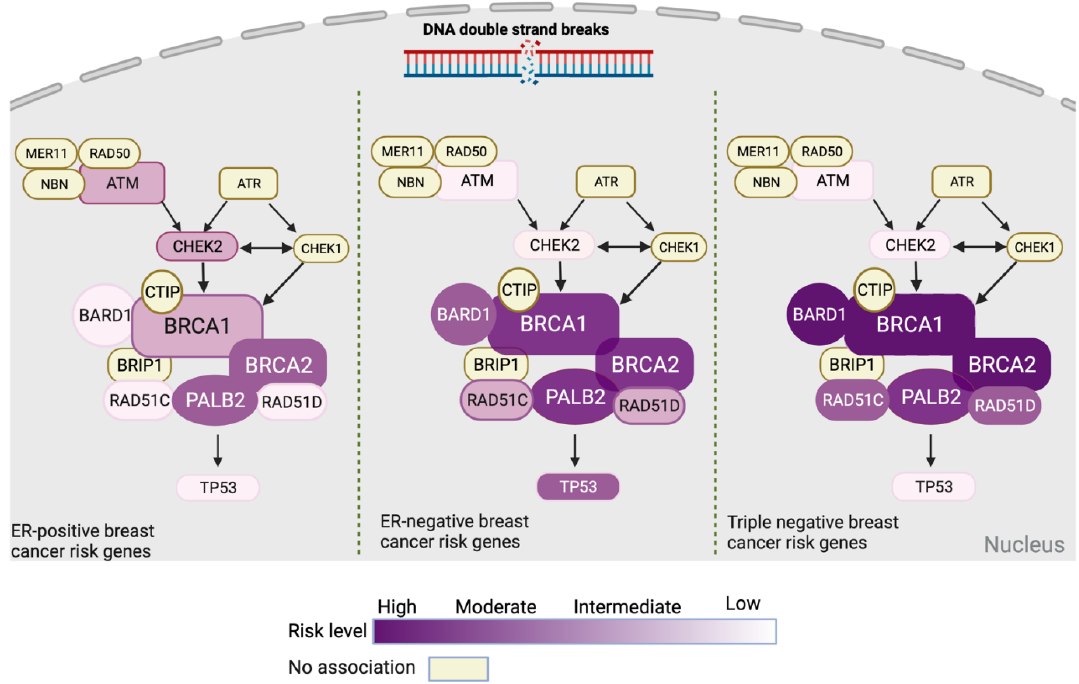
Figure 2. Diagrammatic representation of tumor subtype–associated breast cancer susceptibility genes present in the double-strand DNA break repair pathway based upon the recent study by Breast Cancer Association Consortium et al., 2021 [47]. ER = estrogen receptor. Figures 2–4 were created with Biorender tool (https://biorender.com/, accessed on 6 July